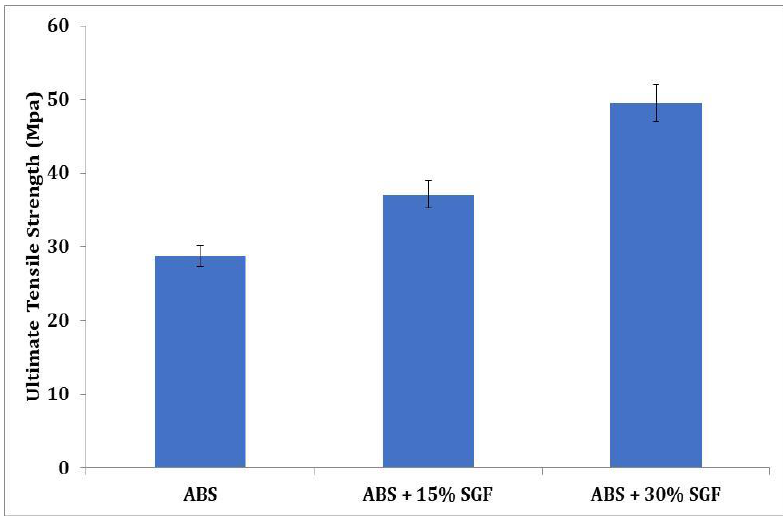
Figure 10. Variation of tensile strength with increase in SGF content. Figure 11 indicates the reduction in elongation with the increased addition of SGF.